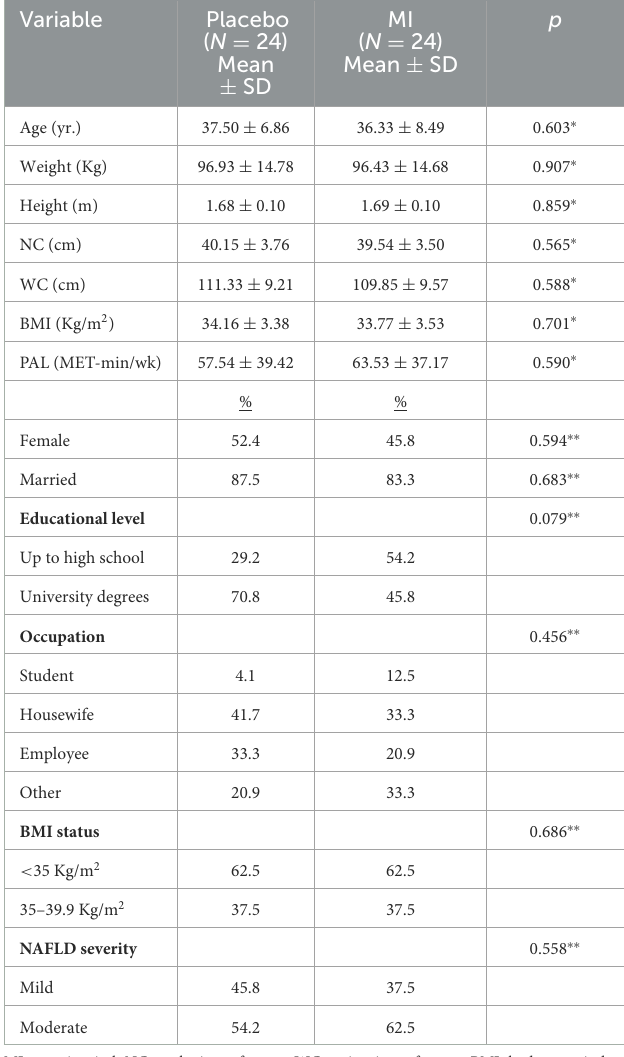
TABLE 1 Baseline characteristics of the study